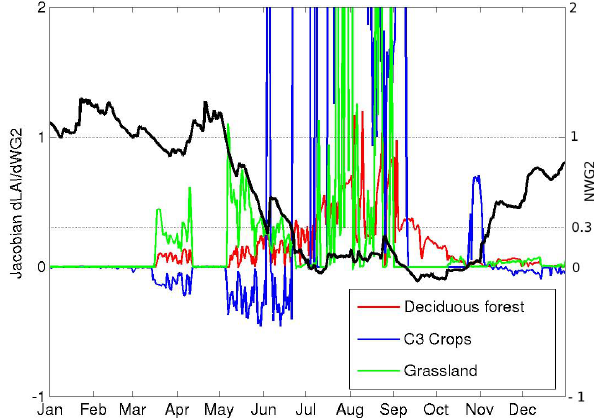
Fig. 4. Time series of daily Jacobian values for the majority patches (deciduous forest, C3 crops and grassland) at a location (43.35 ◦ N, 1.30 ◦ E) in south-west of France for 2009. The simulated nor- malised soil moisture (NWG2) for the C3 crop patch is represented in